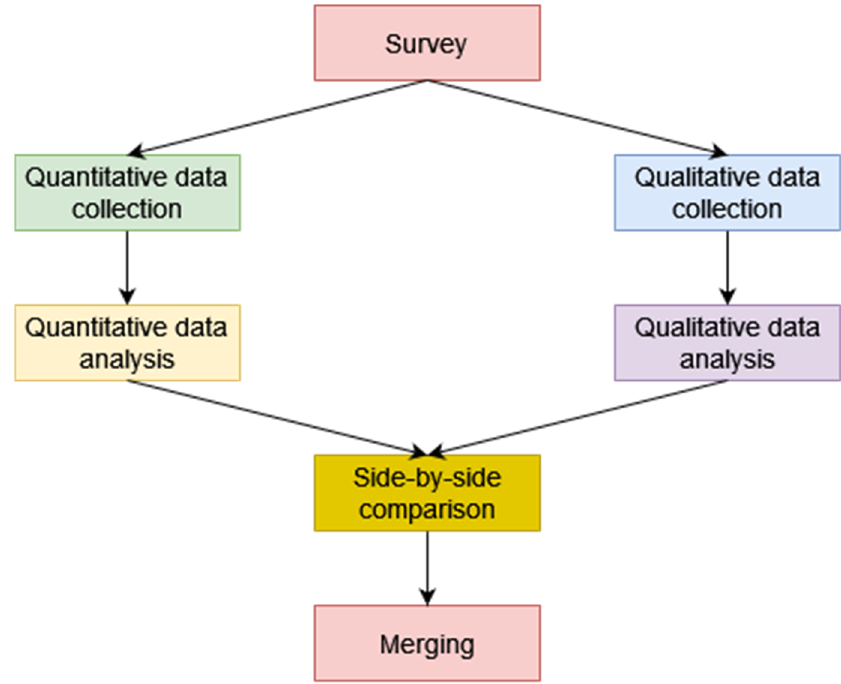
Figure 1. Design diagram of the research study.